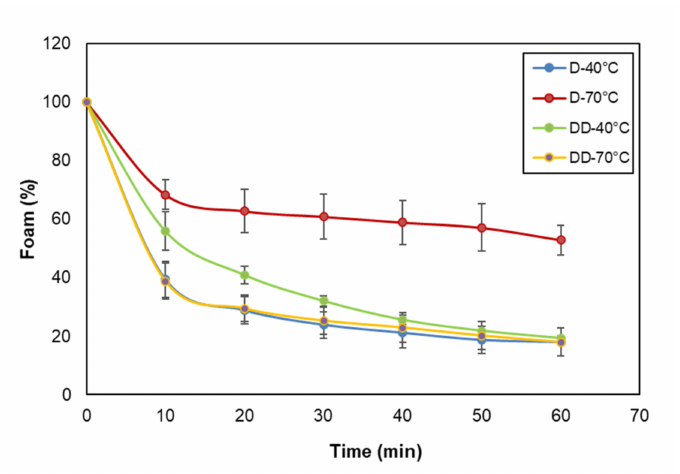
Figure 3. Foam stability (relative percentage of foam) of porcine liver protein solutions (0.5% w / v ) of samples dried (D) at 40 and 70 ◦ C and subsequently defatted (DD) (means ± SD, n =